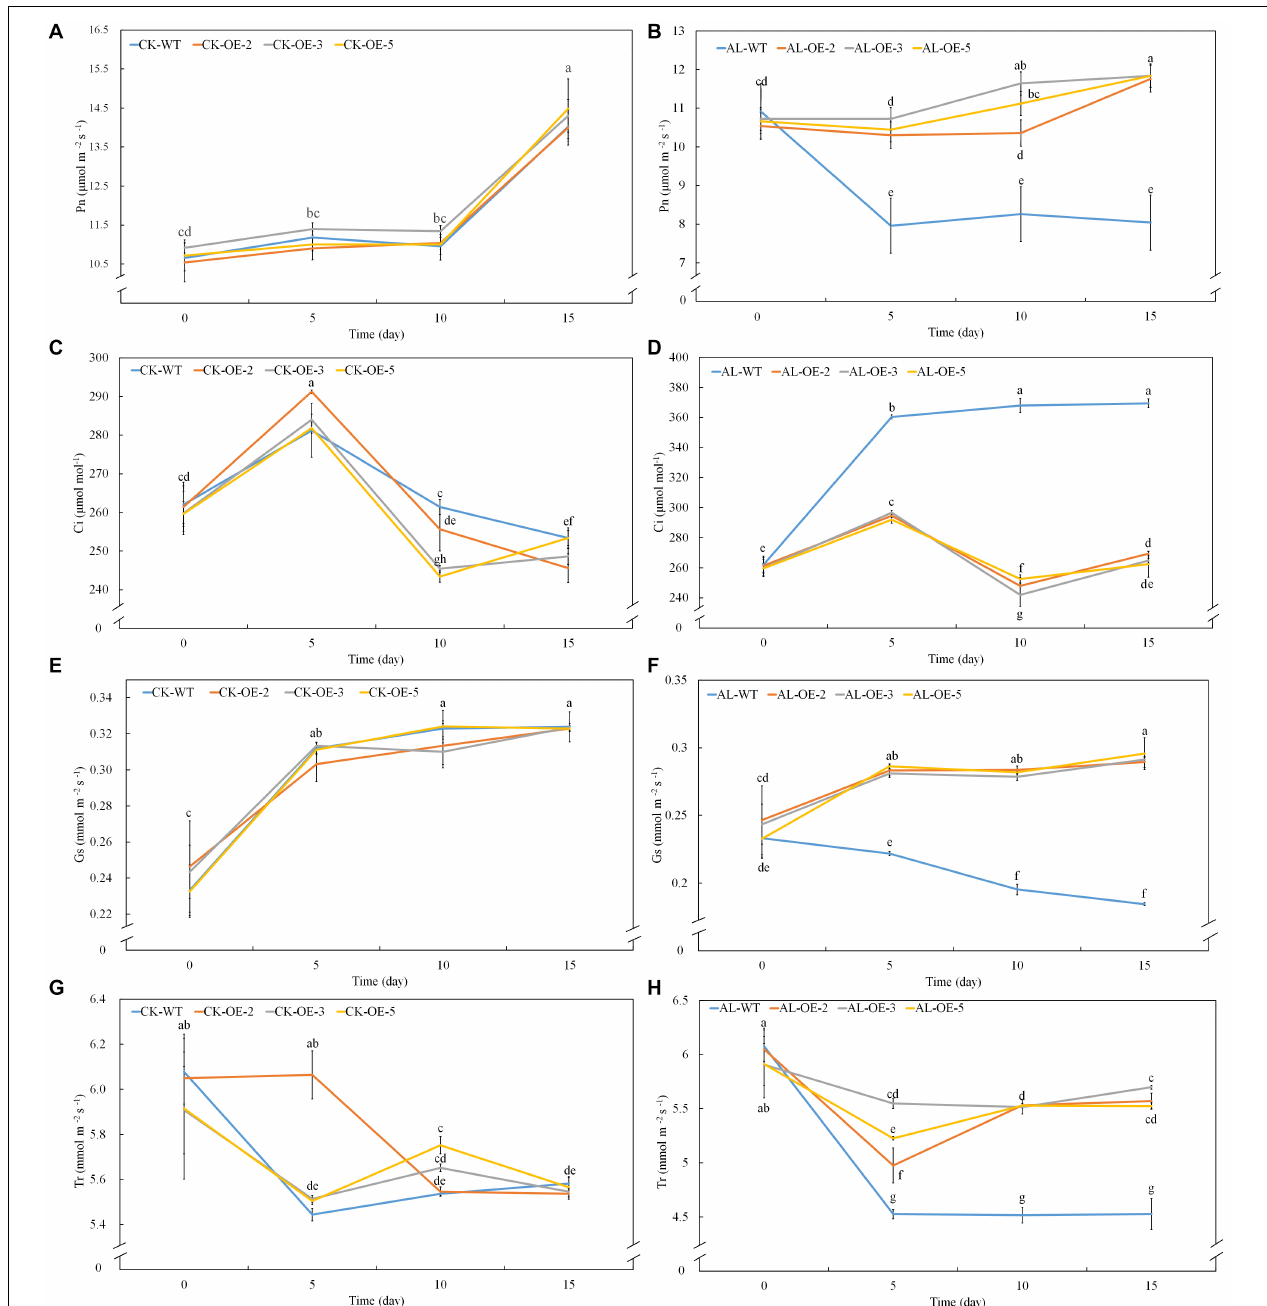
FIGURE 3 | Apple lines overexpressing MdTyDc maintain a stronger photosynthetic system after 15 days under control and alkaline conditions. (A,B) Net photosynthesis (Pn) under (A) control and (B) alkaline conditions, (C,D) intercellular CO 2 concentration (Ci) under (C) control and (D) alkaline conditions, (E,F) stomatal conductance (Gs) under (E) control and (F) alkaline conditions, and (G,H) transpiration rate (Tr) under (G) control and (H) alkaline conditions. The data are presented as means ± SD ( n = 5). Significant differences between WT and MdTyDc overexpression lines are indicated by different lowercase letters based on Tukey’s multi-range test ( P < 0.05). WT, wild type. OE-2, MdTyDc overexpression line 2. OE-3, MdTyDc overexpression line 3. OE-5, MdTyDc overexpression line